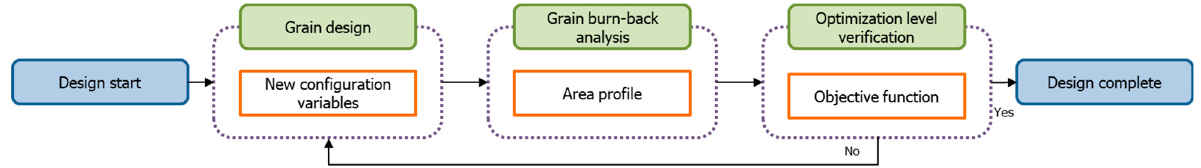
Figure 1. Optimum grain design process.